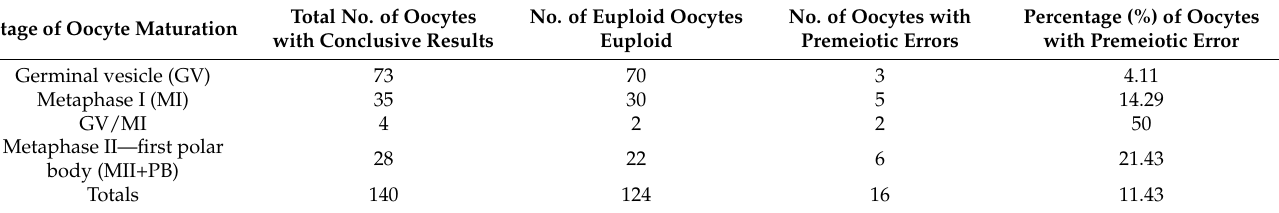
Table 1. Overall summary of NGS results from immature and mature oocyte